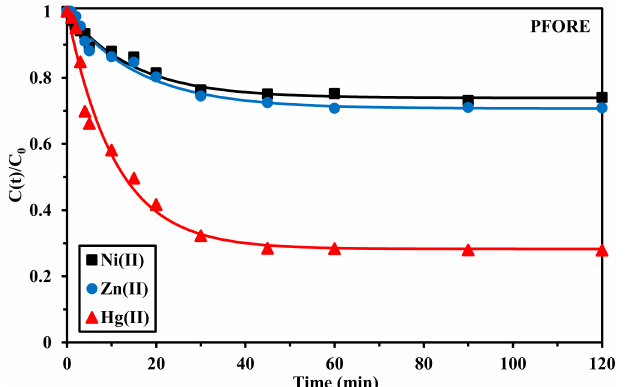
Figure 6. Uptake kinetics for Ni(II), Zn(II) and Hg(II) using G@MChs for multi-component solutions— modeling with the PFORE (C 0 : 0.3 mmol L − 1 ; pH 0 : 5.5; pH eq : 5.75 (Ni), 5.80 (Zn), and 6.01 (Hg); Sorbent dose, SD: 1 g L − 1 ; T: 21 ± 1 ◦ C; time: h; agitation speed: 150